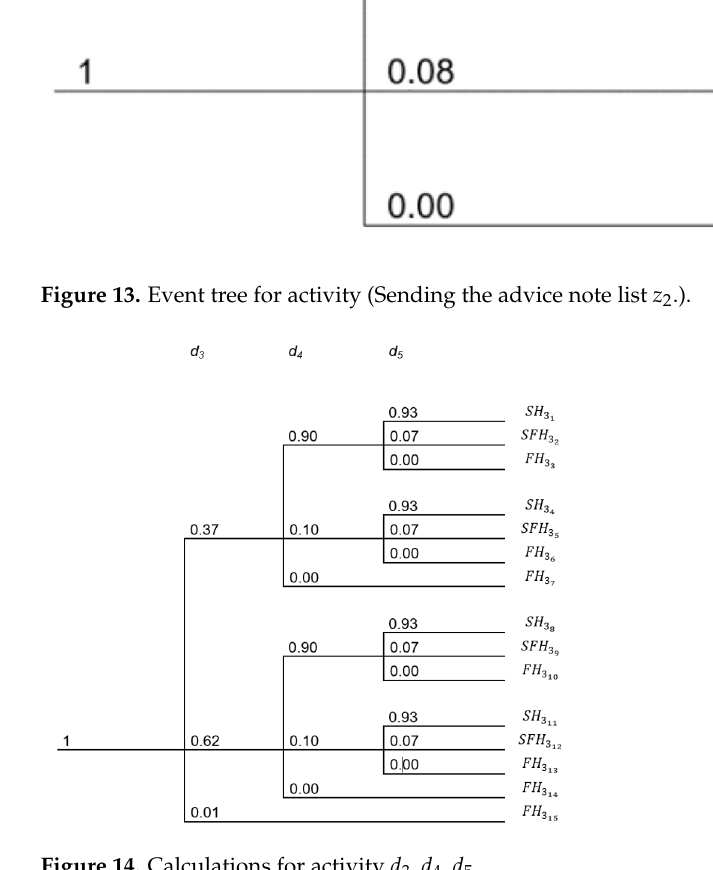
Figure 14. Calculations for activity d 3, d 4, d 5 .